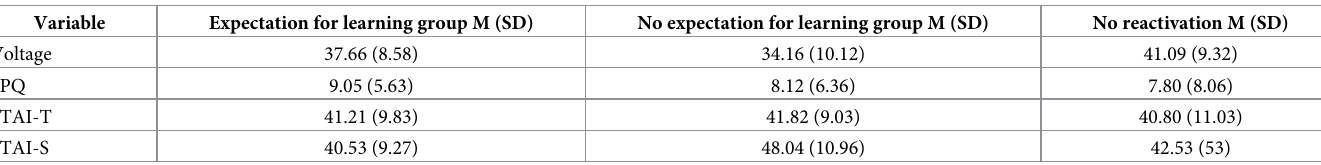
Table 1. Participants means on the anxiety and spider fear measures. Variable Expectation for learning group M